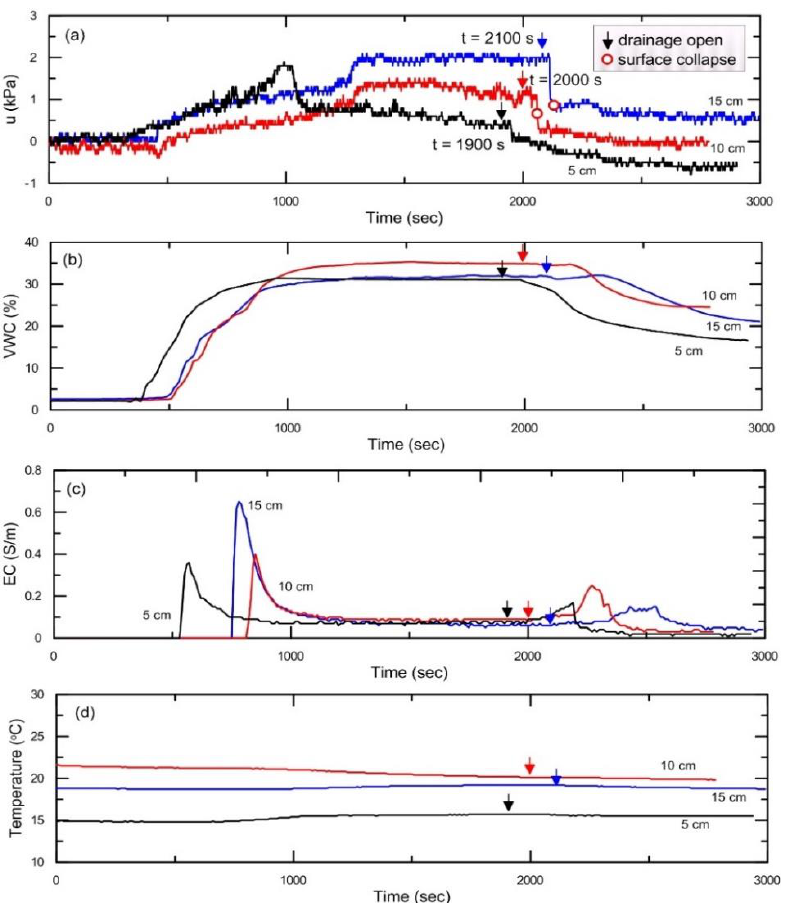
Figure 2. Test results of the variation in groundwater level: ( a ) pore water pressure; ( b ) volumetric water content; ( c ) electrical conductivity; ( d ) temperature.